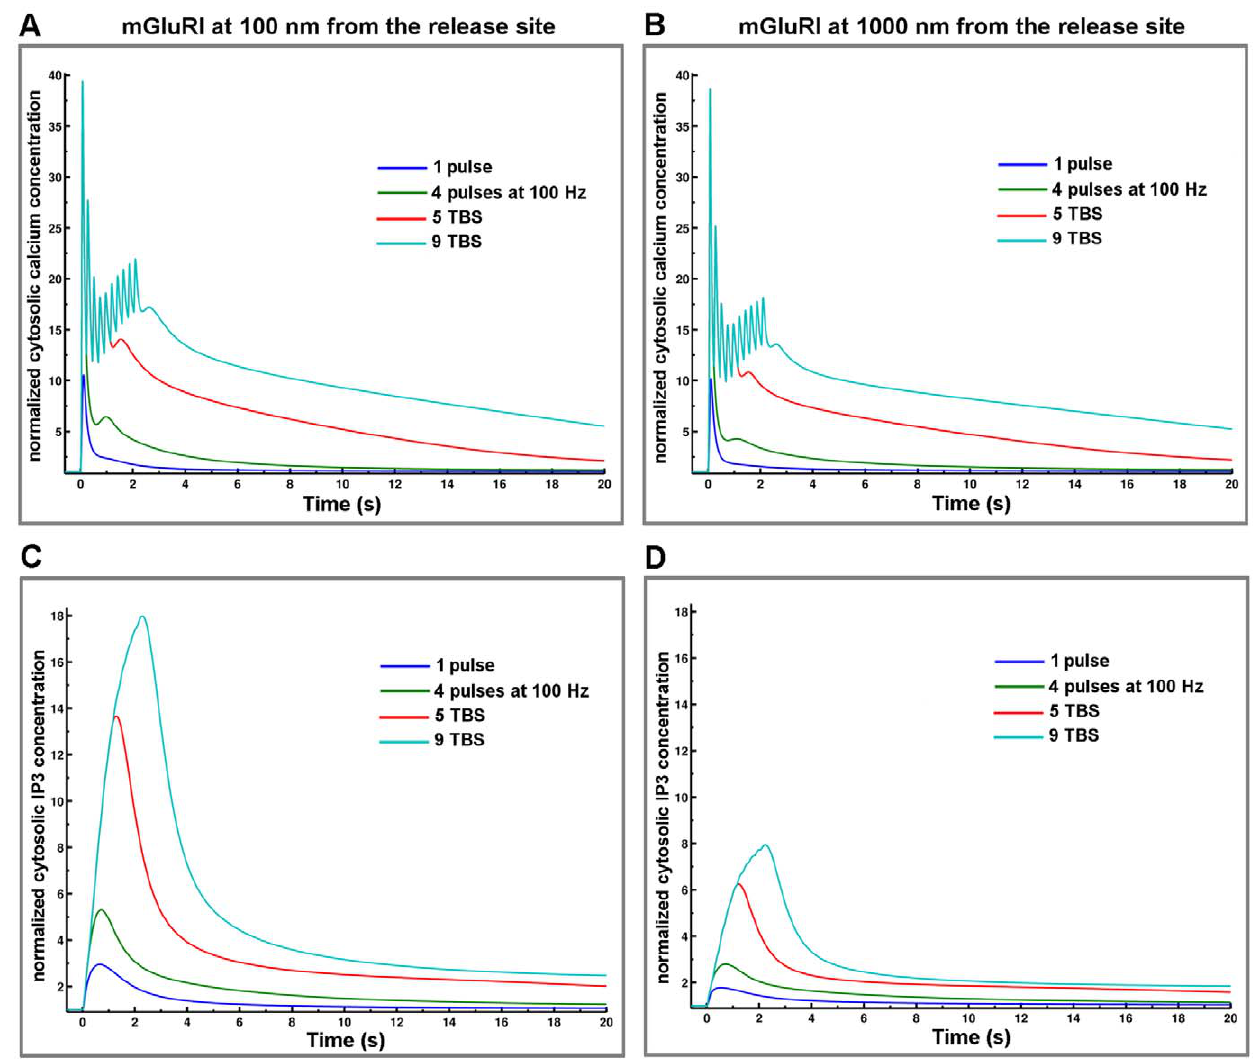
Figure 7. Effects of stimulation patterns and mGluRI location on glutamate-mediated changes in calcium and IP3 cytosolic concentrations. (A,B) Temporal evolution of cytosolic calcium concentration generated by glutamate receptor (AMPA, NMDA and mGluRI receptors) activation in response to one release event, one burst (four releases at 100 Hz), 5 and 9 TBS (repetitive bursts with 200 ms delay between each) with mGluRI located at 100 nm (A) or 1000 nm (B) from the release site. Note the summation effects and decay kinetics following 9 TBS. Calcium responses were normalized to the value of basal cytosolic calcium concentration (60 nM). (C, D) Temporal evolution of the cytosolic IP3 concentration generated by glutamate receptor (AMPA, NMDA and mGluRI receptors) activation in response to the same patterns of stimulation as in A and B with mGluRI located at 100 nm (A) or 1000 nm (B) from the release site. Note the summation effects and decay kinetics following 9 TBS. While mGluRI location has a very large impact on IP3 transients, it has only a weak impact on calcium dynamics. IP3 responses were normalized to the value of basal IP3 concentration (100 nM).